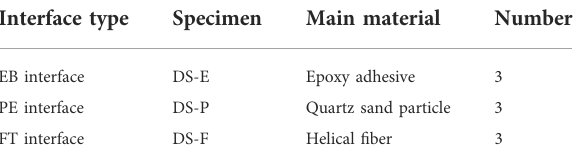
TABLE 1 Design information of